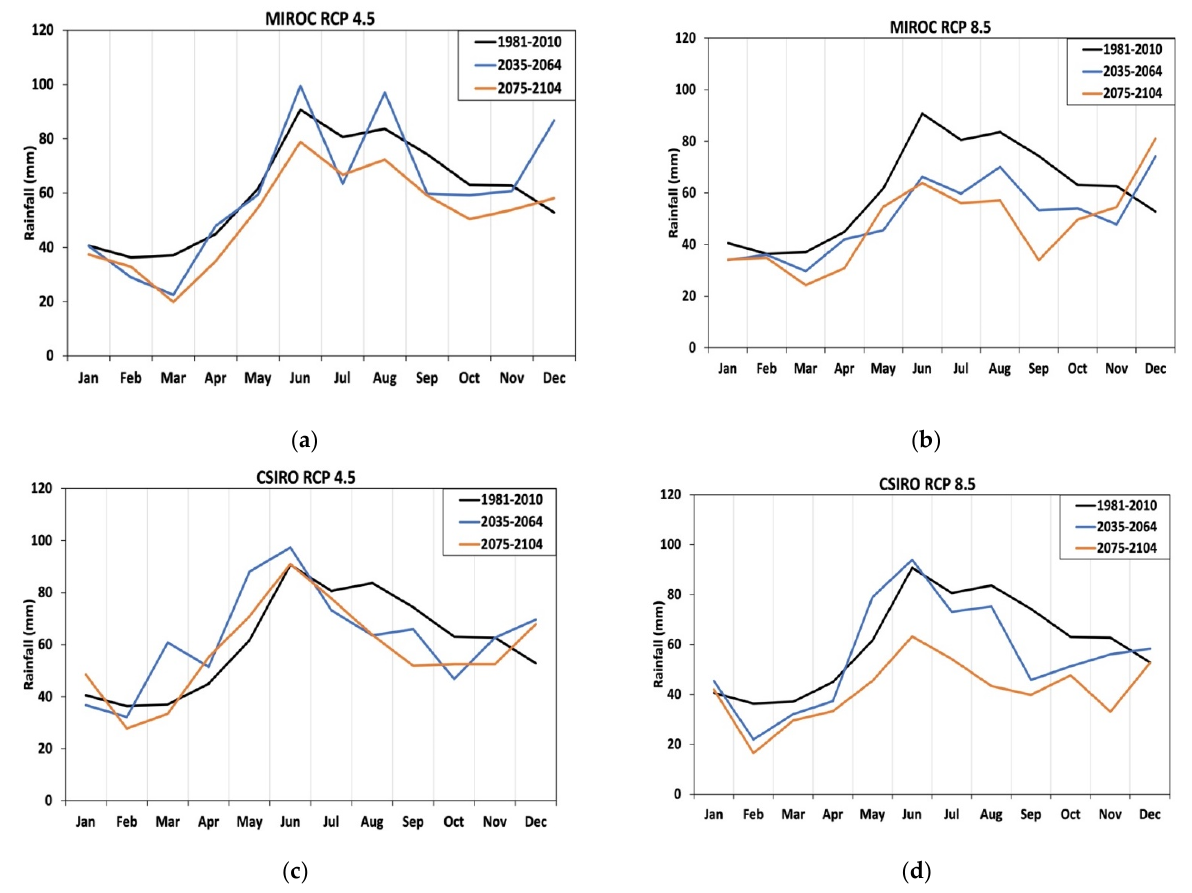
Figure 4. Observed and projected monthly total rainfall: ( a ) MIROC-RCP4.5 model; ( b ) MIROC-RCP8.5 model; ( c ) CSIRO- RCP4.5 model; ( d ) CSIRO-RCP8.5 model.